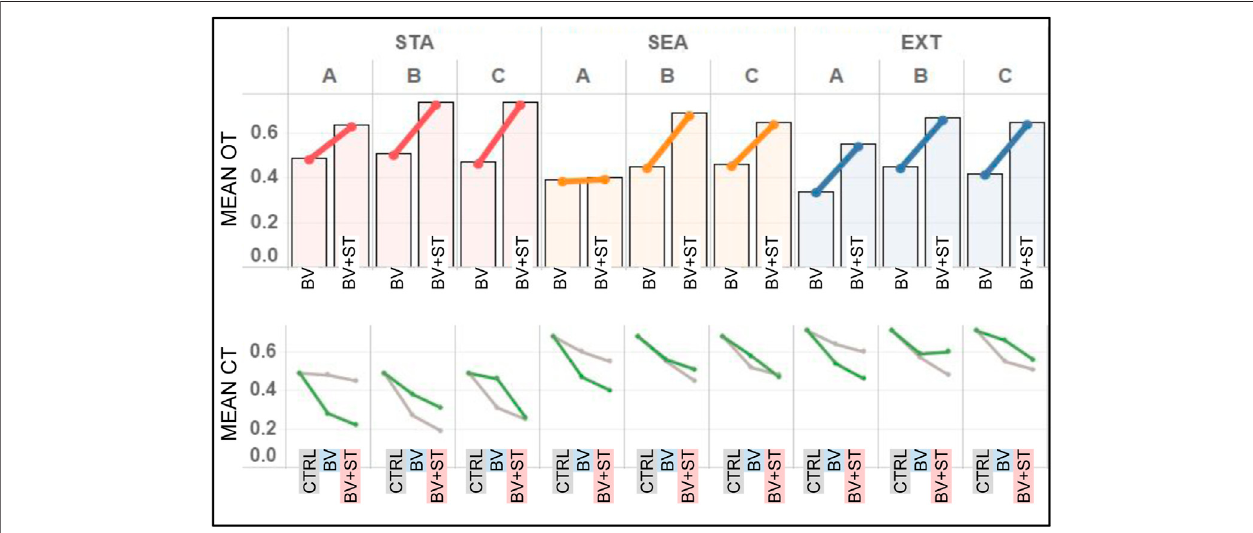
FIGURE 8 | Results for the mean OT and CT levels across all experimental conditions. STA = Static, SEA = Seasonal, and EXT = Extreme world environments, respectively. Bond Conditions are denoted as A, B, and C, respectively. Top: Mean OT levels for bonded agents in both Type BV and Type BV+ST models. Bottom: Mean CT levels for bonded (green line) and unbonded (grey line) agents across Control (CTRL), Type BV, and Type BV+ST